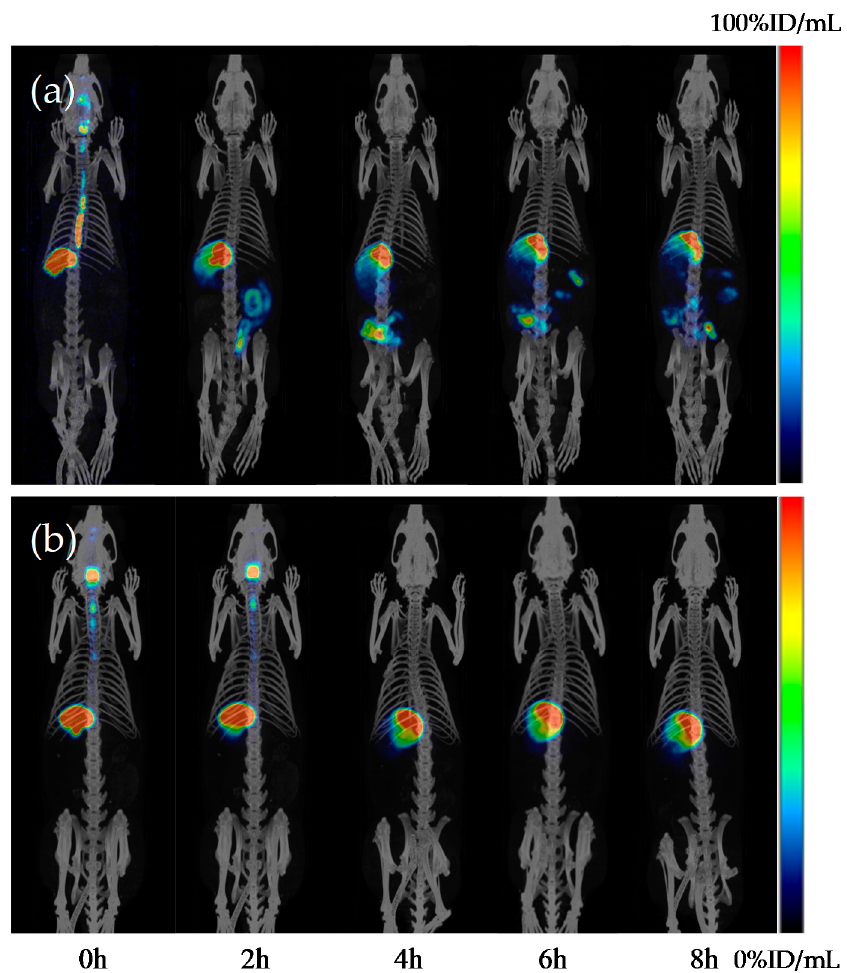
Figure 9. 3D-SPECT scaning images: ( a ) Different organ uptake values of 99m Tc-labeled H-1-2, taken orally, in rats, propagated from the esophagus, stomach, small intestine, the large intestine, and then to the bladder with time. The gastric emptying time for H-1-2 was about 8 h; ( b ) Contrast group free technetium propagated from the esophagus, a major amount of the radioactivity was concentrated in the stomach and there was no uptake into the intestine; n = 3.